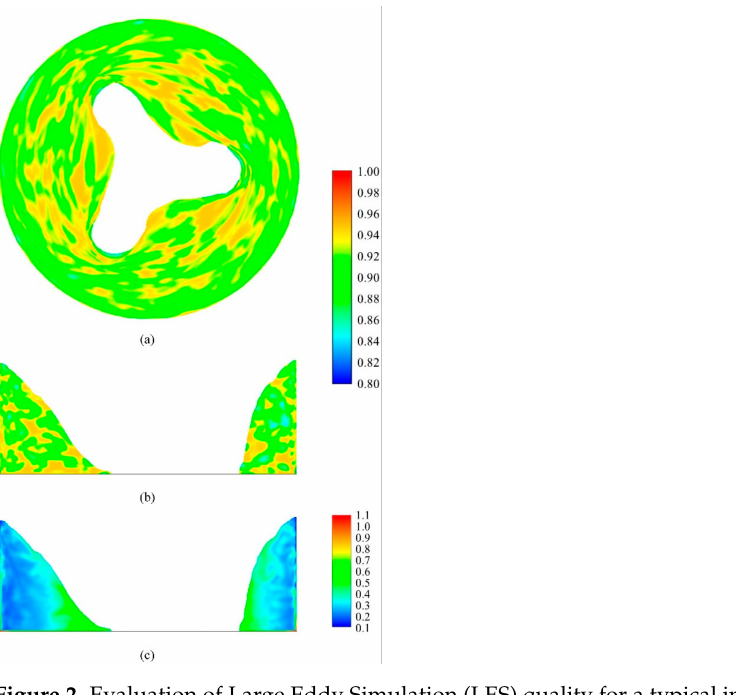
Figure 2. Evaluation of Large Eddy Simulation (LES) quality for a typical instant flow field: ( a ) LES index of quality (LESIQ ν ) for a free distorted surface shown in top view; ( b ) LESIQ ν for a vertical cross-section of the same flow field; ( c ) the Courant number for the same cross-section. No-slip and no-penetration boundary conditions are applied on the rotating bottom disk and the vertical cylinder wall. The top boundary of the computational domain was defined as pressure outlet. As the domain height in all the computations was larger than the uppermost height reached by the water level, only air flow crossed the top boundary, without the liquid being “spilled” out from the computational domain. In fact, instantaneous velocity field shows some of the air leaving the computational domain, while the same amount is drawn back due to continuity constraint, since the flow is treated as